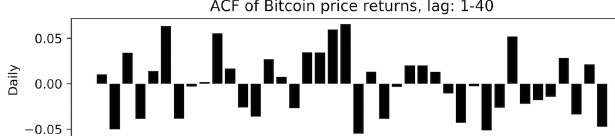
Figure 5: Autocorrelation function of Bitcoin daily price returns (Jan 2015 - Feb 2018)